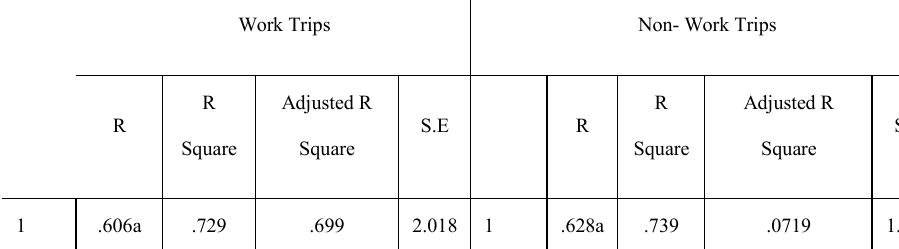
Table 2: Summary of the Model